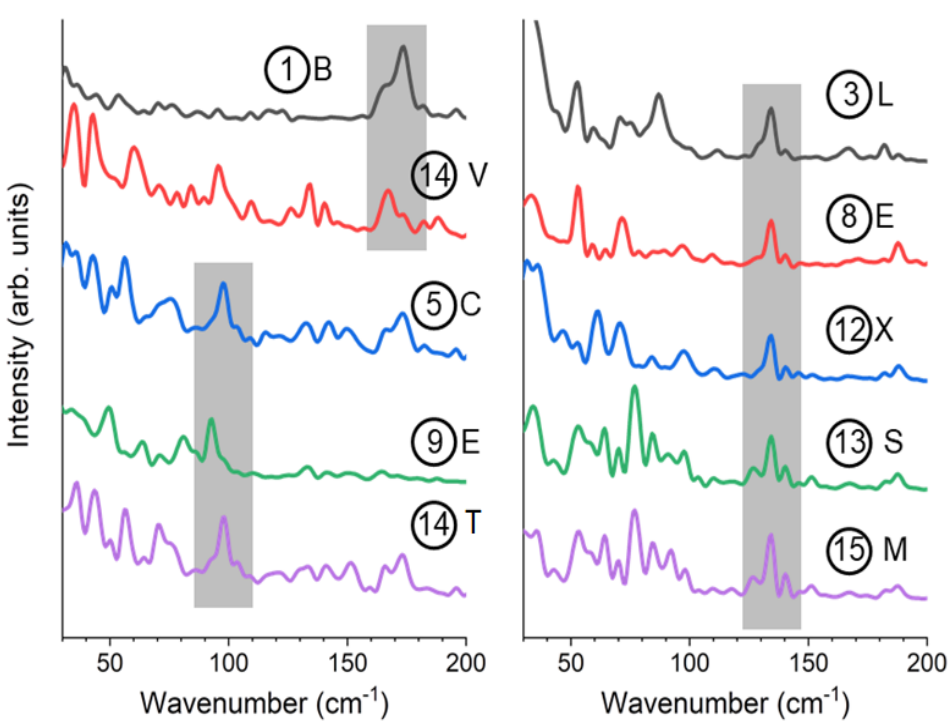
Figure 8. Simulated spectra showing characteristic peaks selected from Figure 7. The number in the circle and the uppercase letters correspond to those shown in Figure 6. Colors of the curves are to distinguish the curves and do not have specific meaning. The 175 cm − 1 and 90 cm − 1 peaks are hatched in gray in the left panel, and the 135 cm − 1 peaks are hatched in the right panel. Circled numbers and letters show the point of calculation.